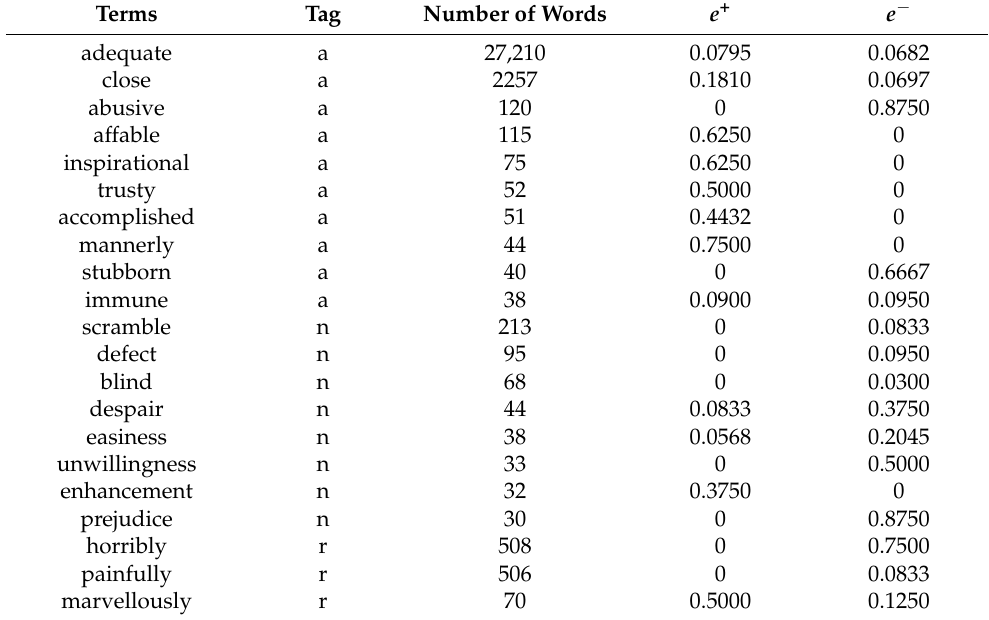
Table 5. Candidate sentiment words with tag, frequency and initial sentiment